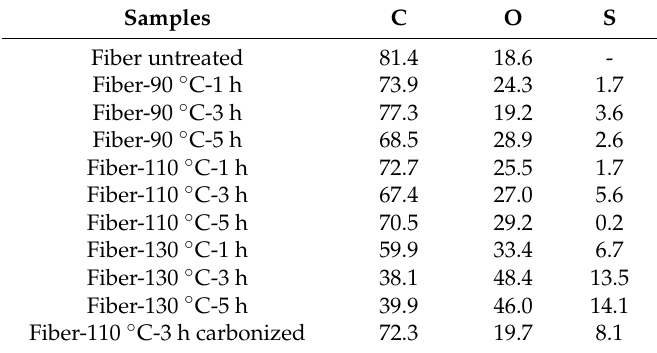
Table 1. Tabulated values of wt % element concentration of the produced HDPE/SKL fibers.